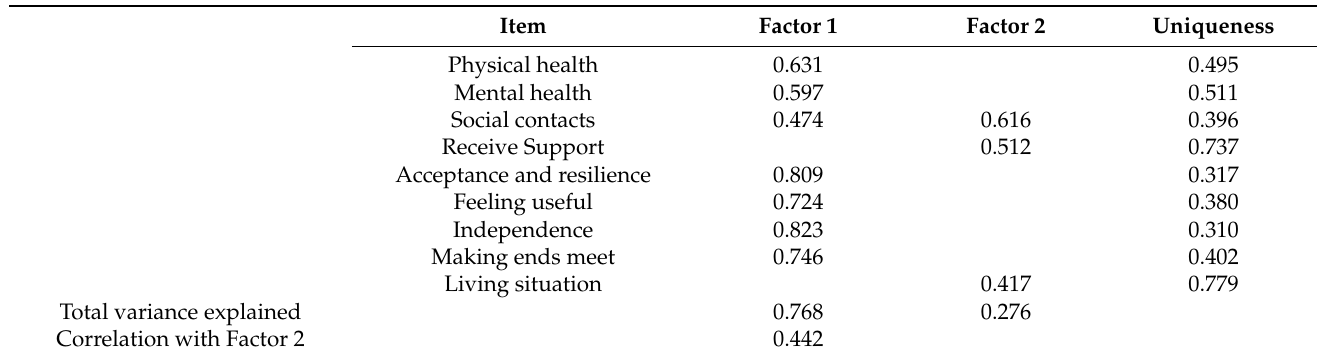
Table 3. EFA results.